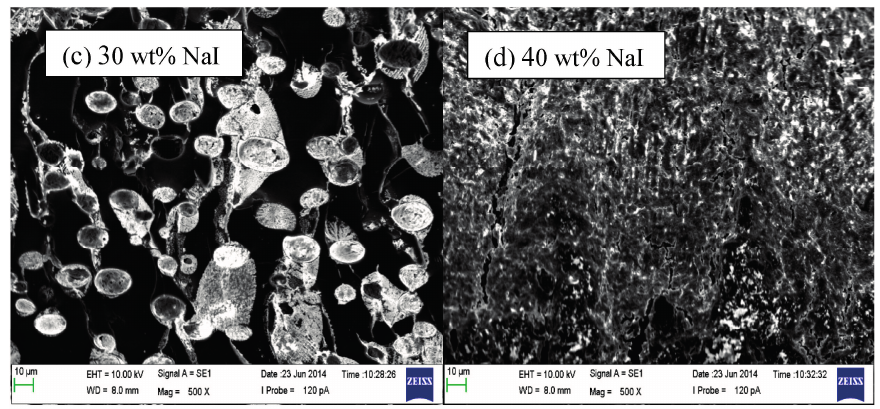
Figure 6. Cross-sectional morphological images of P(MMA- co -EMA) + NaI polymer electrolyte films.